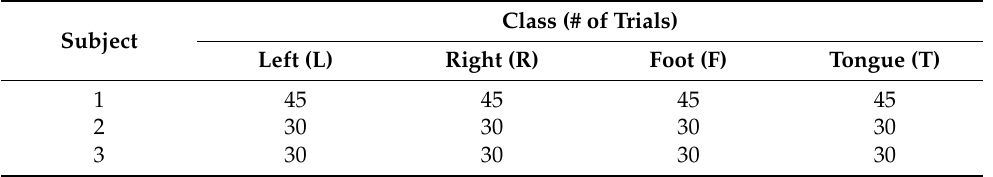
Table 1. The C3D3a_4C dataset composed of three subjects and predefined number of experimental